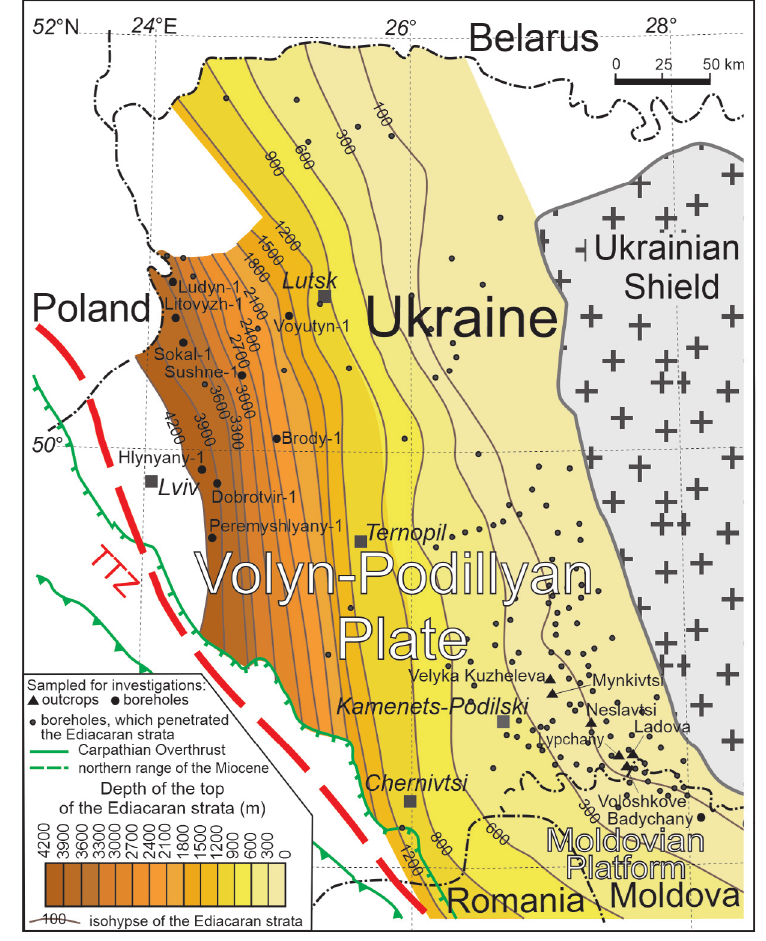
Fig. 4. Structural map of the top of the Ediacaran strata of the Volyn-Podillyan Plate and the NW Moldovian Platform. The map was constructed using the well-log data from the archives of the Institute of Geology and Geochemistry of Combustible Minerals of NAS of Ukraine as well as of sections, published by Velikanov et al. (1983) and Chebanenko et al. (1990). TTZ, Teysseyre-Tornquist Zone.